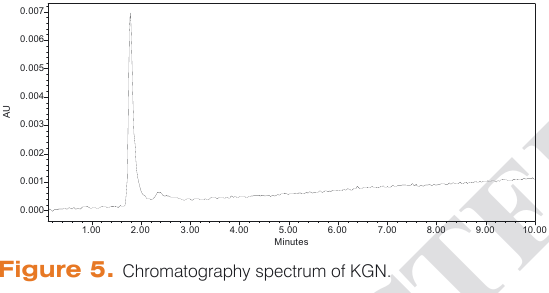
Figure 5. Chromatography spectrum of KGN.